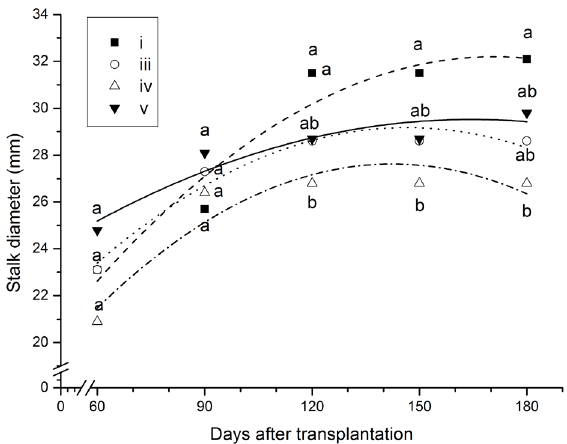
Figure 3 - Intercropping effects on the stalk diameter of sugarcane plants: (i) sugarcane monocropping, iii) sugarcane cropping intertwined with morning glory but in separate boxes, (iv) sugarcane cropping intertwined with morning glory in attached boxes and (v) sugarcane intercropping with morning glory in attached boxes without intertwining with the sugarcane. Means followed by the same letter in each period are not different from one another at 5% probability according to Tukey’s test.